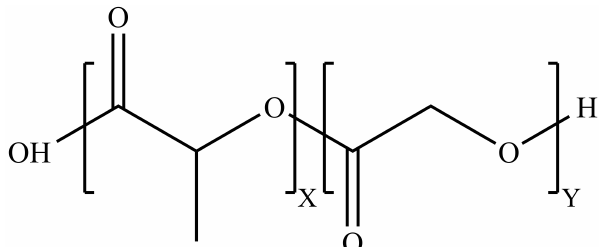
Figure 14. Chemical structure of the copolymer poly(lactic)-co-(glycolic) acid (PLGA), which is widely used in drug-delivery applications. X represents the number of units of lactic acid and Y represents the number of units of glycolic acid.